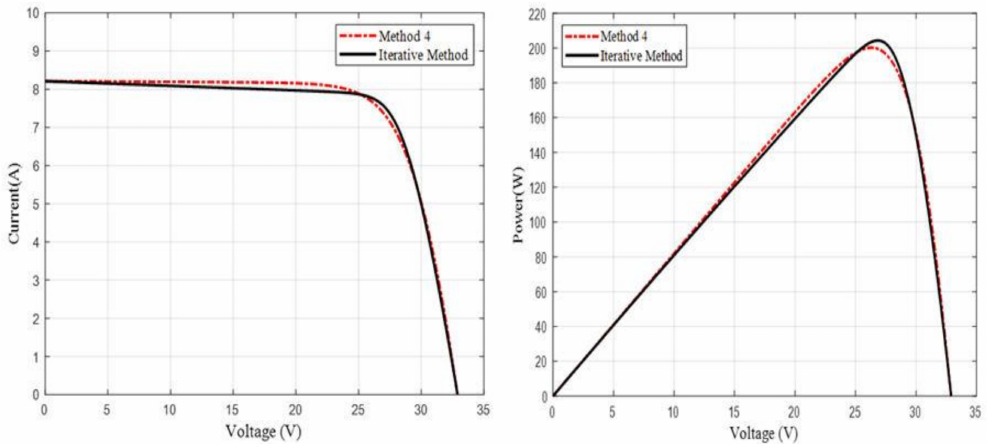
Figure 7. Comparison between the I–V ( left ) and P–V ( right ) curves obtained using Method four with those obtained using numerical method for the KC200GT